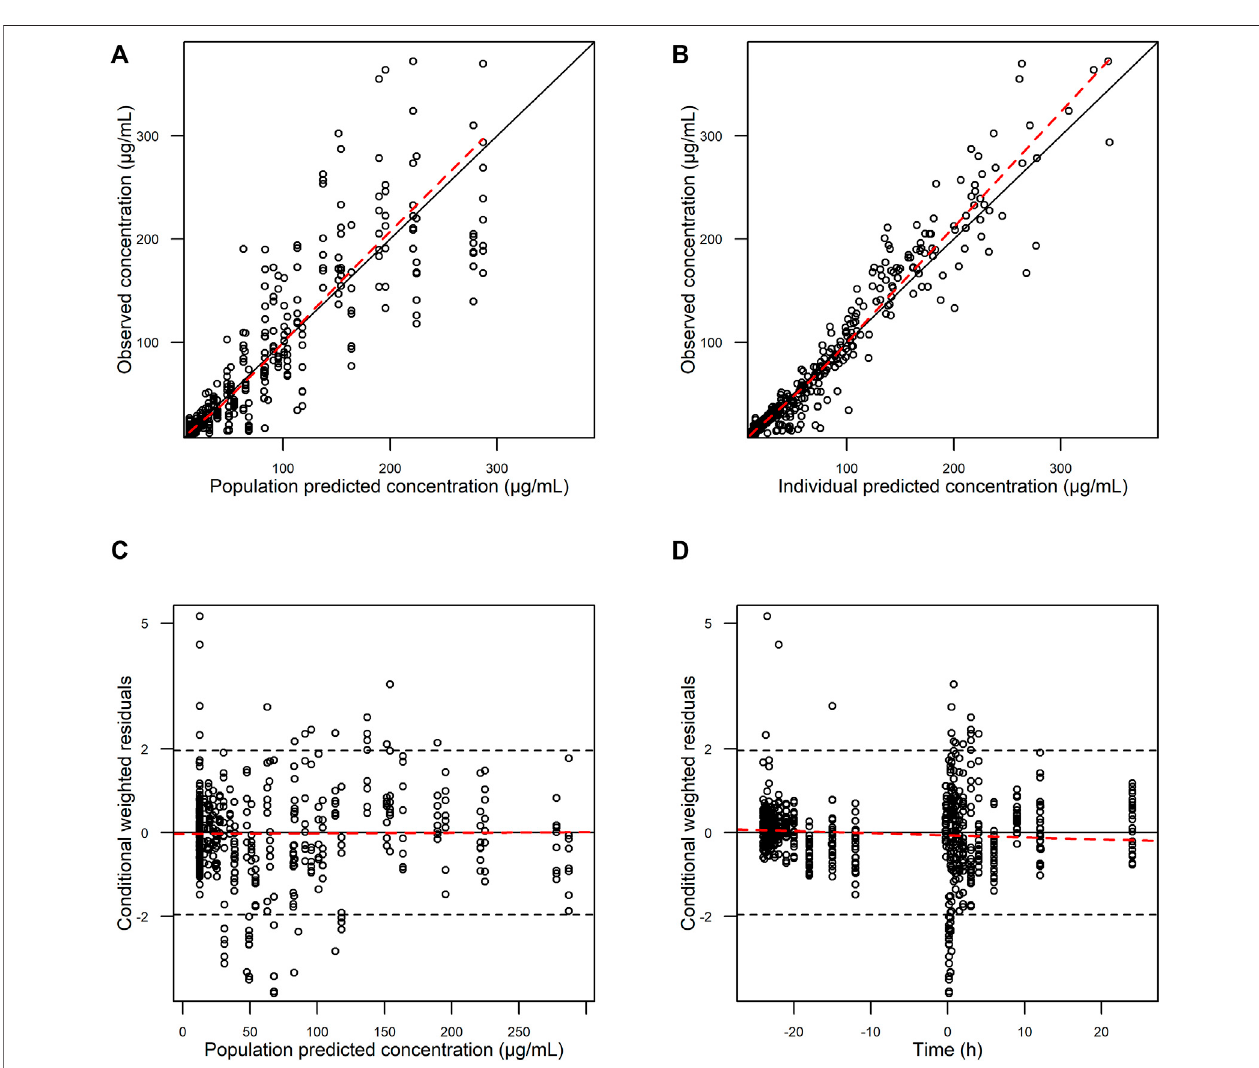
FIGURE2| Basic goodness-of- fi tplotsof fi nal AST-001 PKmodel. (A) observations versuspopulationpredictions; (B) observations versusindividual predictions; (C) conditional weighted residuals versus population predictions; (D) conditional weighted residuals versus time.